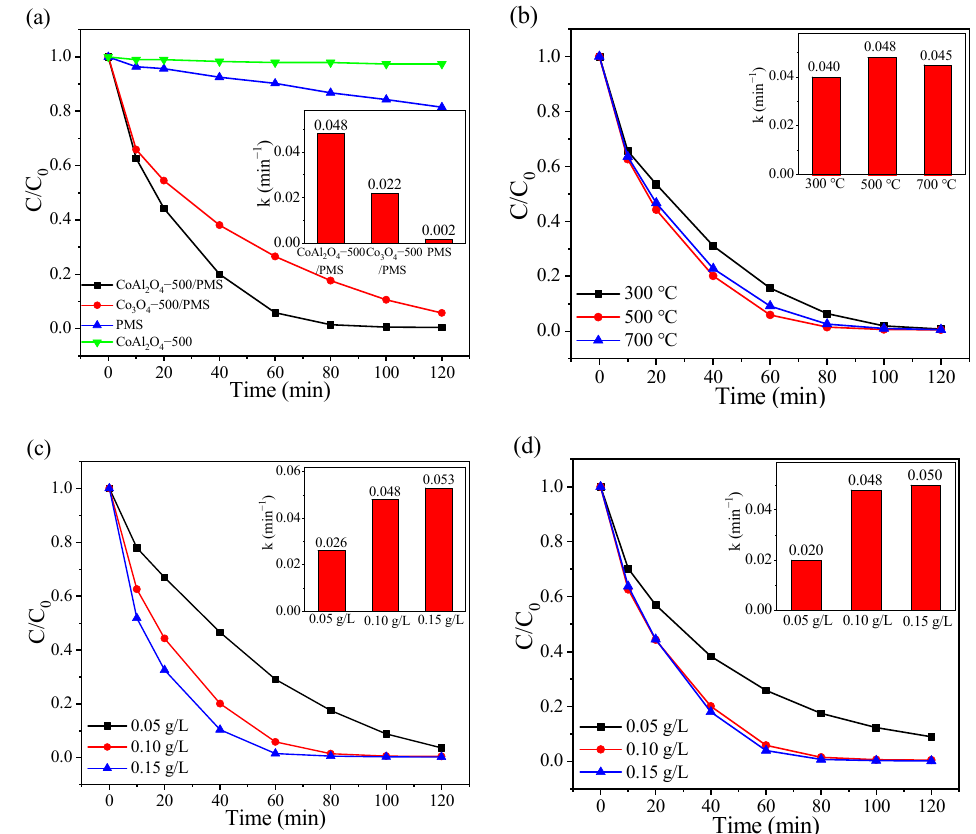
Figure 2. ( a ) RhB degradation in various systems; effects of ( b ) calcination temperature; ( c ) catalyst dosage, and ( d ) PMS dosage on the RhB degradation and their corresponding pseudo-first-order model kinetic results (inset) in the CoAl 2 O 4 − 500/PMS system.